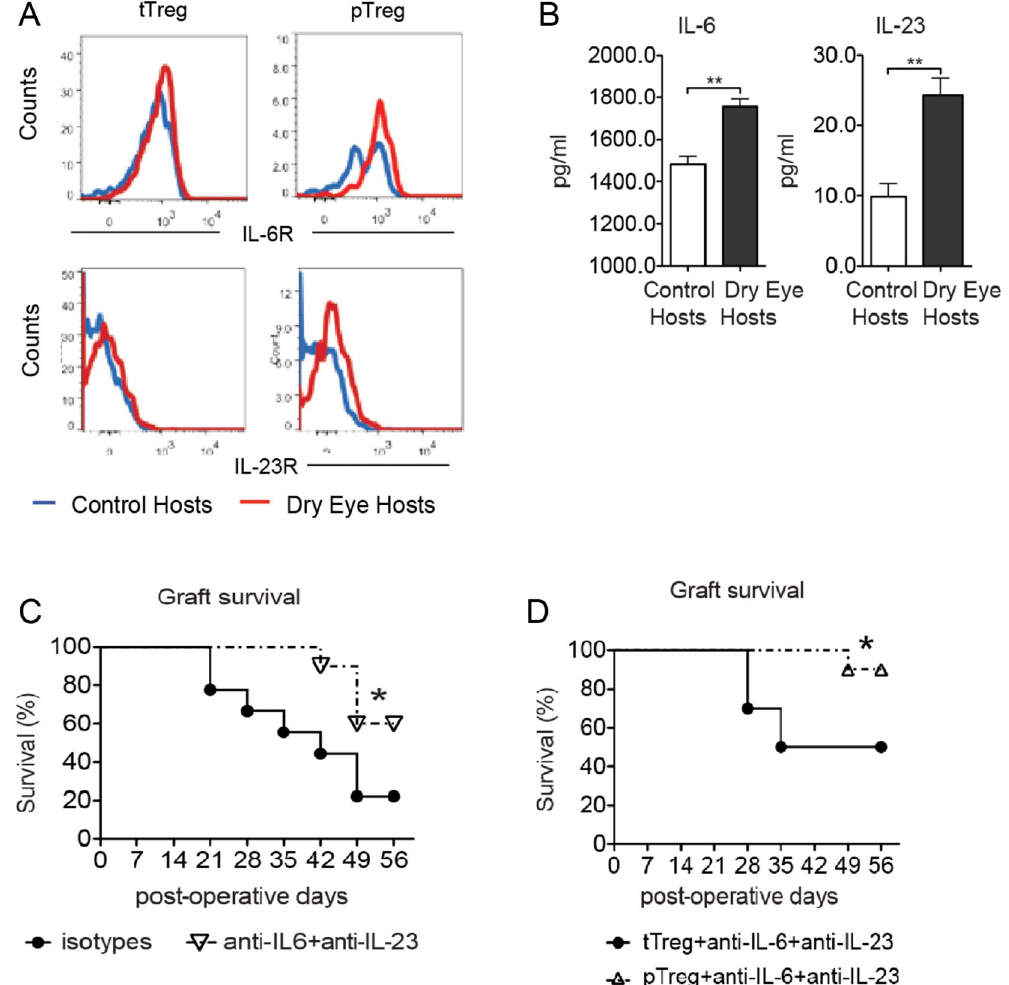
Figure 4. Blockade of IL-6 and IL-23 promotes allograft survival. Draining lymph nodes were harvested 2 weeks post-transplantation. Single cell suspensions were analyzed by flow cytometry. ( A ) Flow cytometry analysis of IL-6R and IL-23R expression by Nrp1 + tTregs and Nrp1 − pTregs from draining lymph nodes of control and DED hosts. ( B ) ELISA analysis showing IL-6 and IL-23 protein levels in the supernatant of explanted draining lymph nodes of healthy control and dry eye (DED) hosts (n = 4, p = 0.0015 and 0.0086, respectively; unpaired two-tailed Student’s t-test). ( C ) Allograft survival of DED hosts treated with anti-IL-6 and anti-IL-23 antibodies or isotype-treated control hosts are shown (n = 10, χ 2 = 4.525, * p = 0.0334,